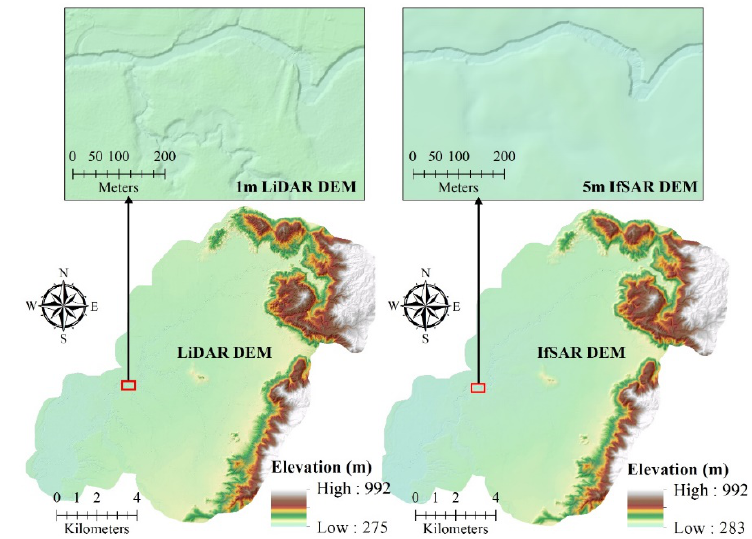
Fig. 3: Processed LiDAR and IfSAR DEMs